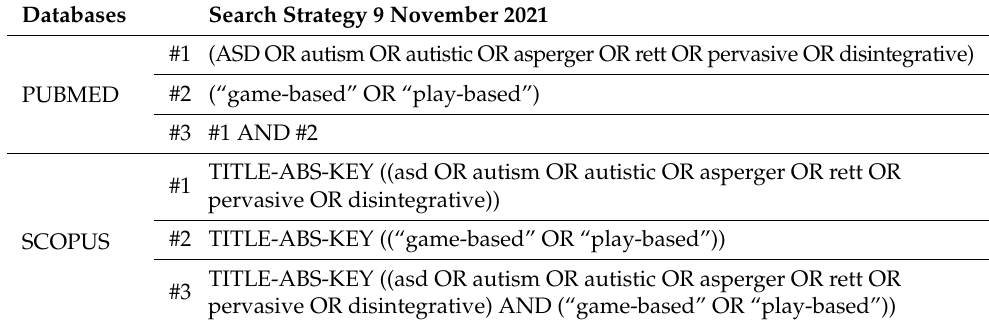
Table 1. Databases and search strategies